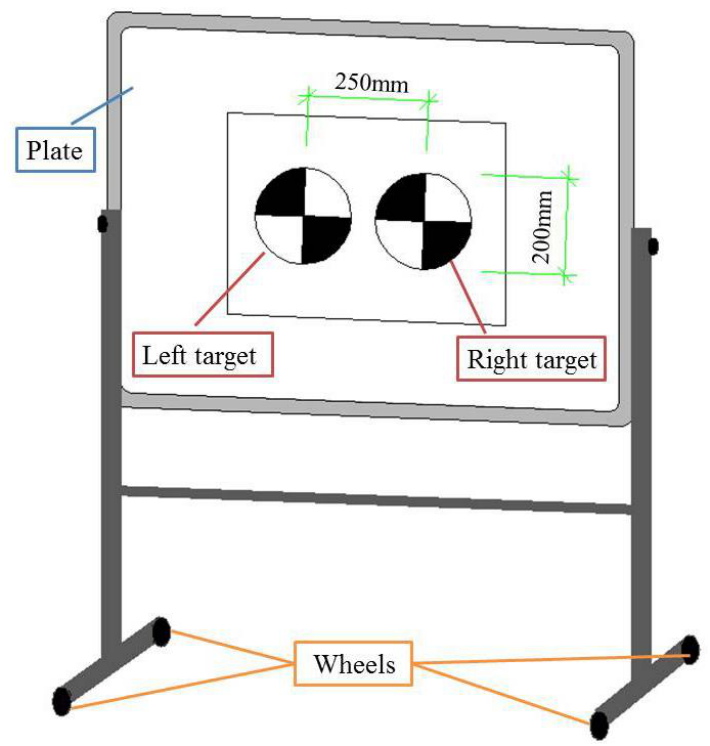
Figure 4. Diagram of removable platform of sliding deformation simulation test.